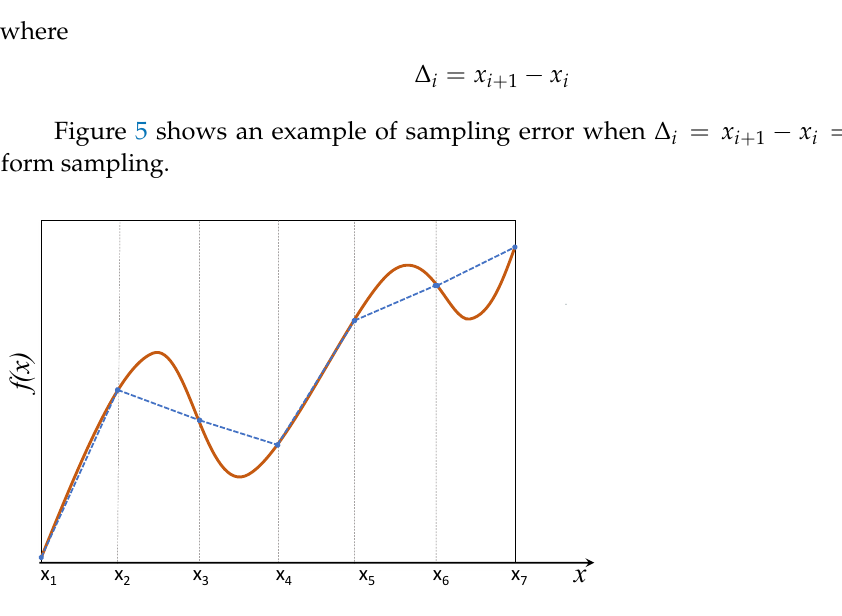
Figure 5. Uniform sampling: It can be seen that uniform sampling error (samples shown in dotted blue) increases with the magnitude of the curvature (function shown in